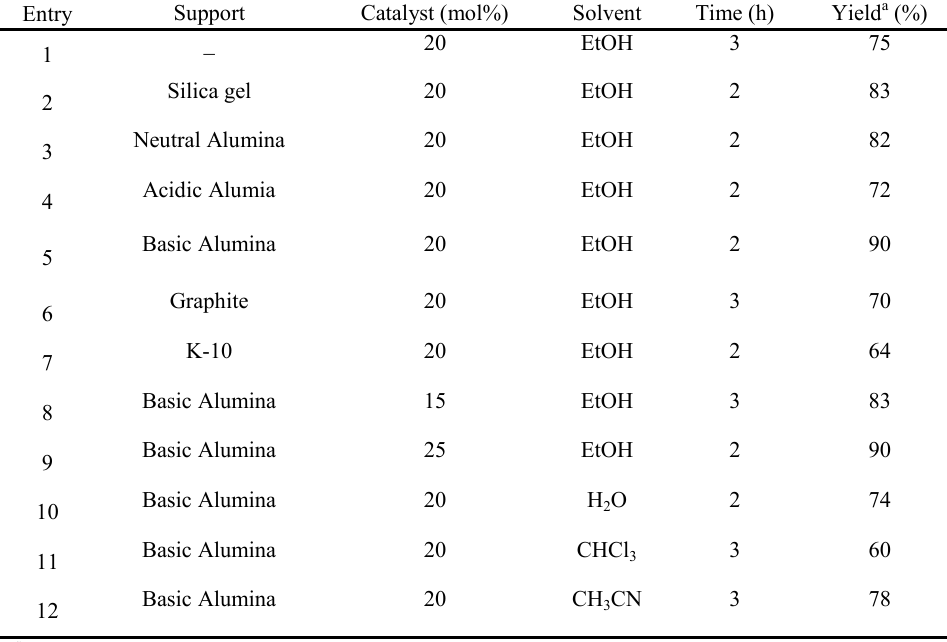
Table 1 : The effect of different supports on synthesis of benzo[b]pyran ( 4a ) in different solvents under reflux